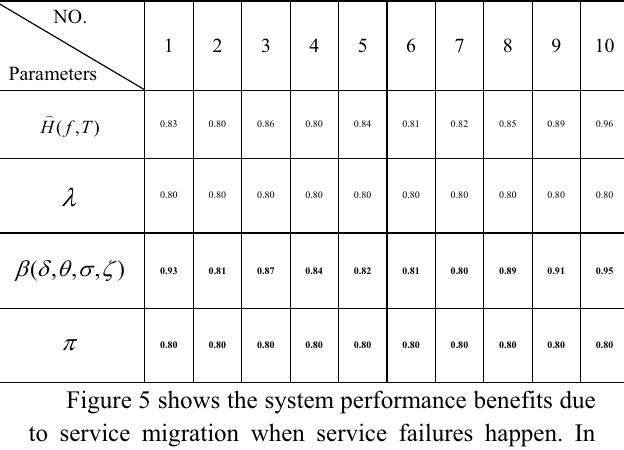
Table 3. Important parameters of relevant to service migration